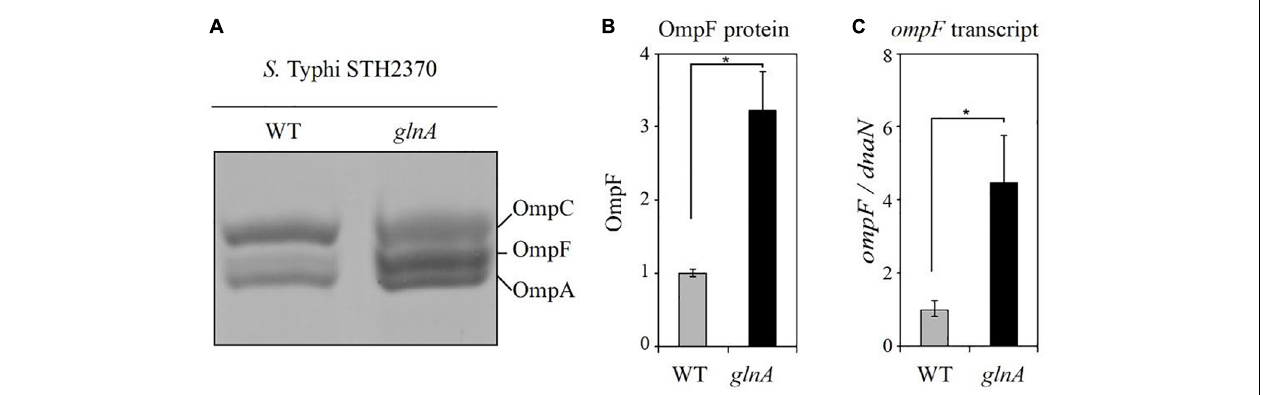
FIGURE 2 | The glnA mutant has increased OmpF. (A) OMPs profile from S . Typhi STH2370 (WT) and S . Typhi STH2370 glnA:: FRT ( glnA ). (B) Densitometric analysis of the OmpF porin in the glnA mutant compared with WT strain. Analysis was performed by using the ImageJ software, as described in Section “Materials and Methods.” (C) Expression level of ompF transcripts in the glnA mutant compared with the WT strain. Expression of ompF transcripts was normalized to expression of dnaN and compared to the expression of ompF in the WT strain. The figure shows the mean of three assays. Asterisks indicate significance, calculated by Student’s t -test, of results linked by brackets ∗ p ≤ 0.05.